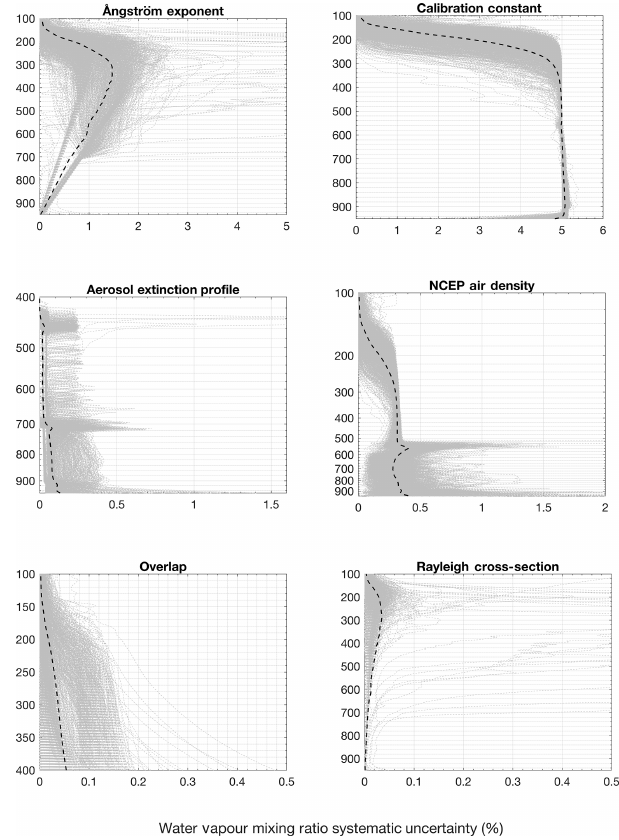
Figure 6. The monthly geophysical variability of water vapour mea- sured by RALMO as a function of pressure. The largest amount of variability can be seen in the free troposphere between 600 and 400hPa in the summer and from 800 to 450hPa in the